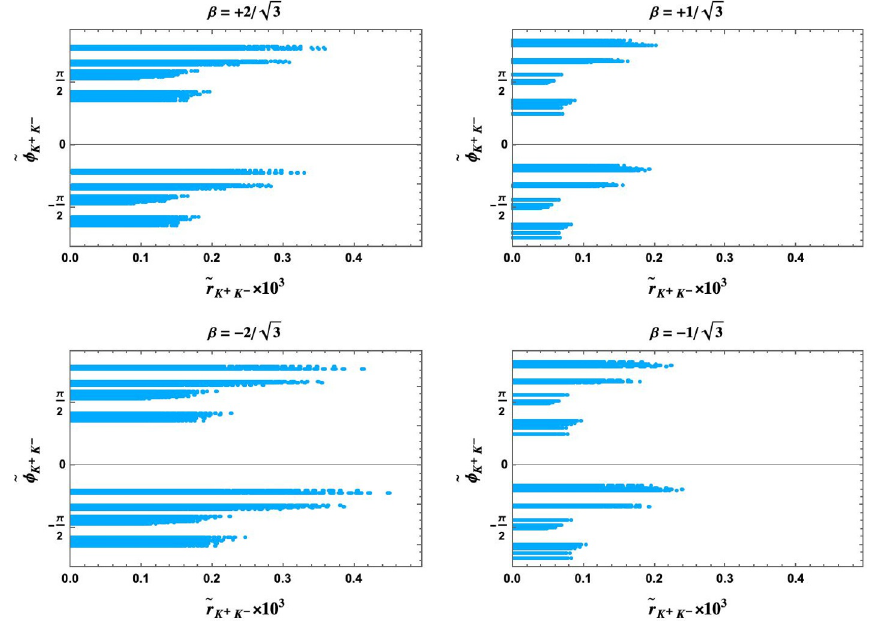
and phase ˜ φ in (4.5) in 331 models with K + K − K + K − and phase ˜ φ in (4.6) in 331 models, as described π + π − π + π −